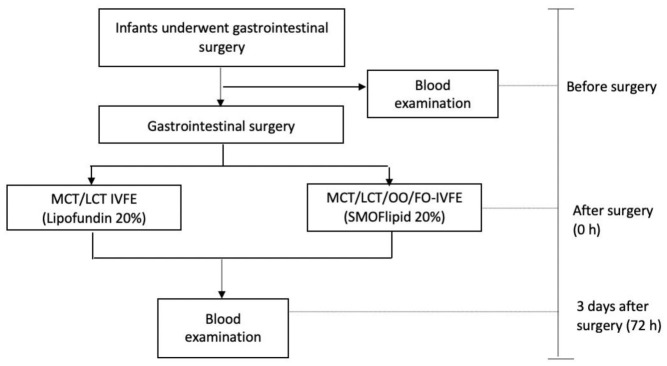
Study flowchart.